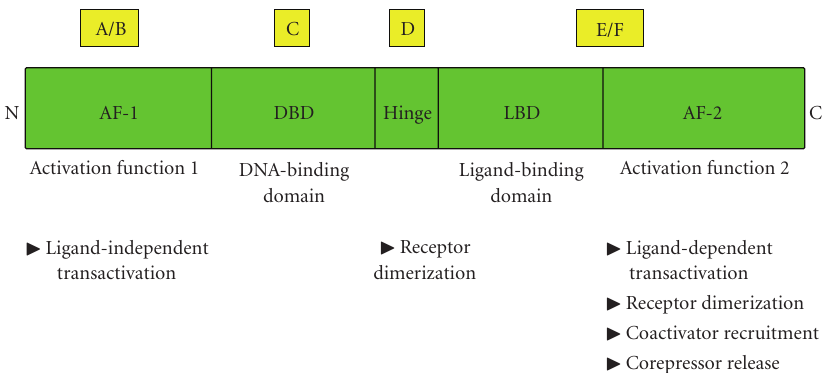
Figure 1: Schematic structure of the functional domains of nuclear receptors. The activation domains AF-1 and AF-2 are located at the N- terminal and C-terminal regions, respectively. C domain is a highly conserved DNA-binding domain. D domain is a highly flexible hinge region. E/E domain is responsible for ligand-binding and converting nuclear receptors to active forms that bind DNA. Adapted from [29].